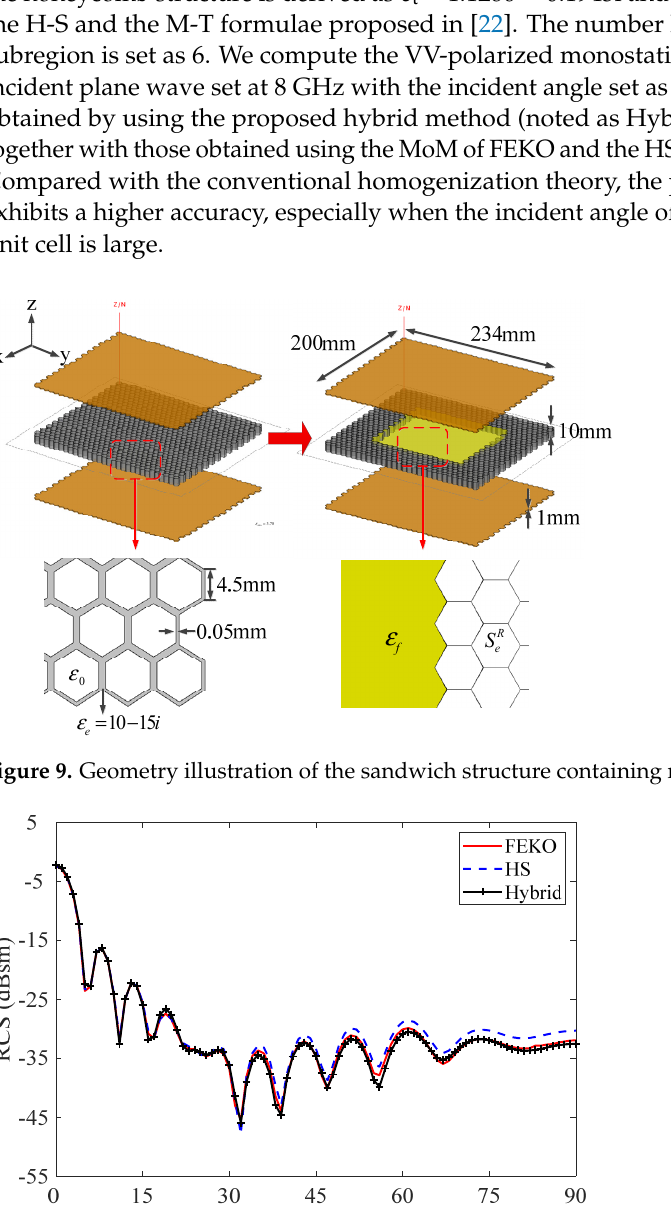
10 of 14 Figure 8. RMS as a function of operating frequency with size r=4.5 mm. Next, we demonstrate the efficiency and accuracy of the proposed hybrid approach